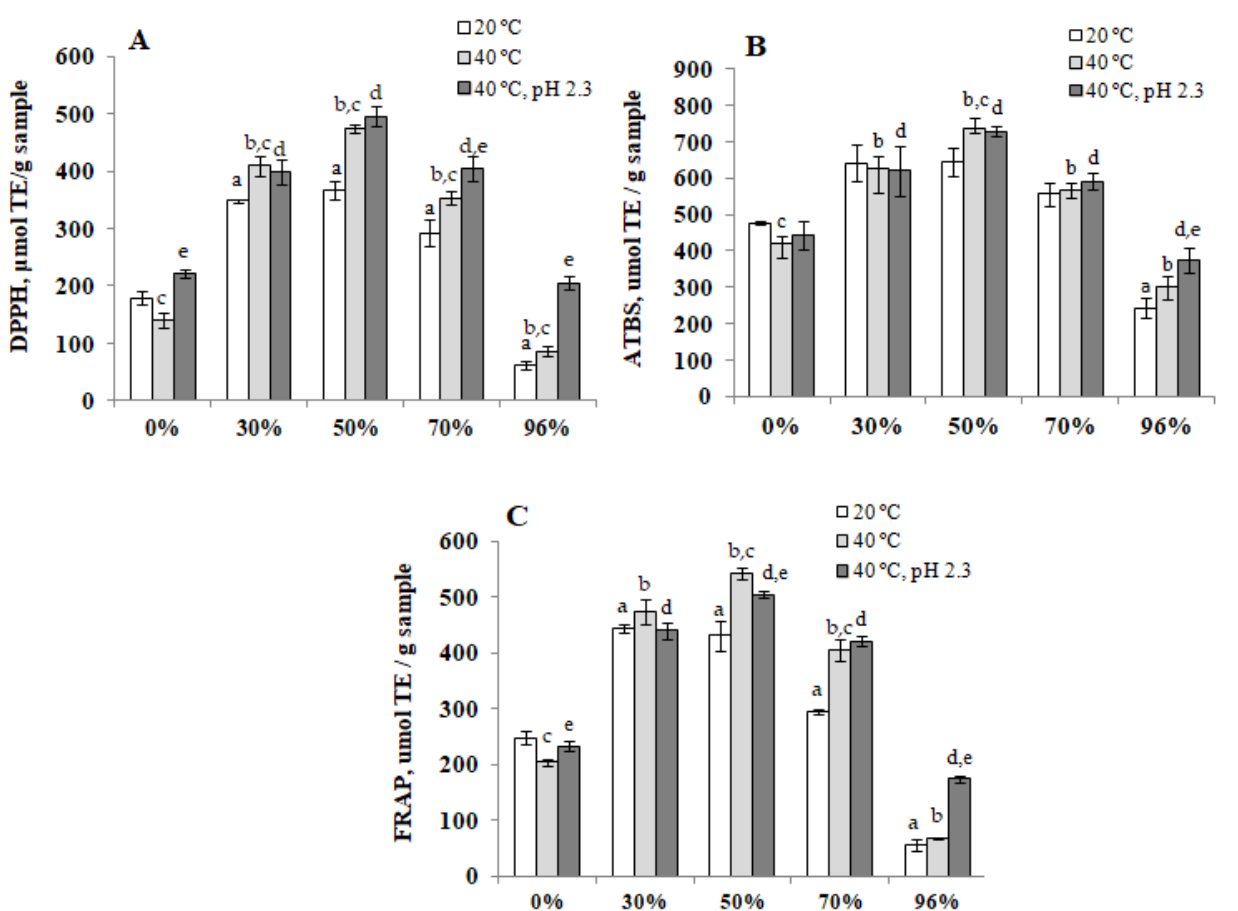
Figure 7. Antioxidant activity ( A , B ) and iron-reducing ability ( C ) of water and water-ethanol extracts of yacon leaves. a —Significantly different from the 0% ethanol, 20 °C ( p < 0.05); b —significantly different from the 0% ethanol, 40 °C ( p < 0.05); c —significantly different from the water-ethanol extracts, 20 ° С ( p < 0.05); d —significantly different from the 0% ethanol, 40 °C ( p < 0.05); e —significantly different from the water-ethanol extracts, 40 °C ( p < 0.05).